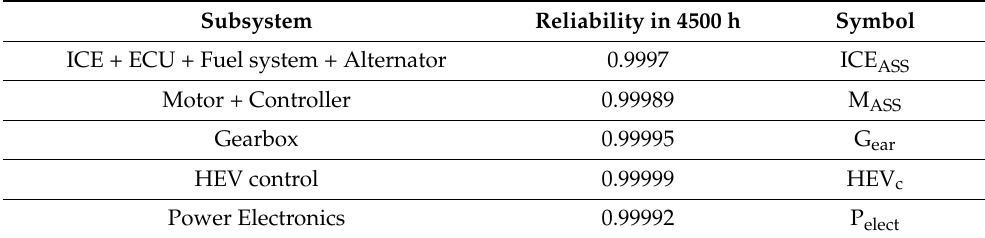
Table 4. Reliability of SHEV